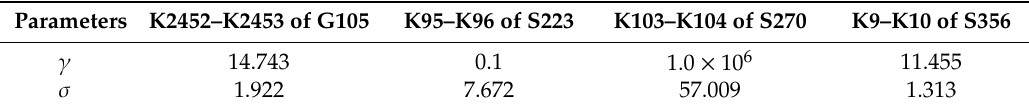
Table 4. Optimized parameters of the PSO–LSSVM model for the four test sites.